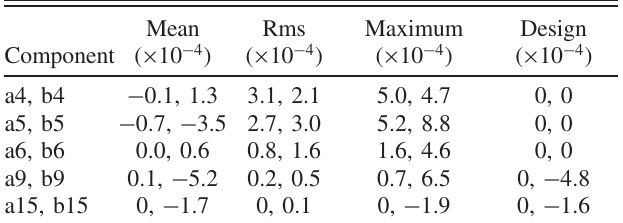
TABLE IV. Magnetic measurement results for the DDBA sextupoles (100